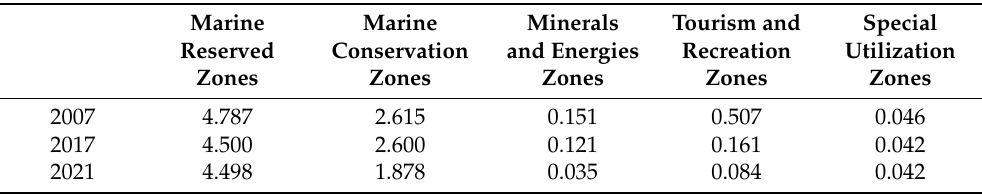
Table 5. Statistics on conflict ratio of reclamation activities in different marine spatial planning zones (Unit: